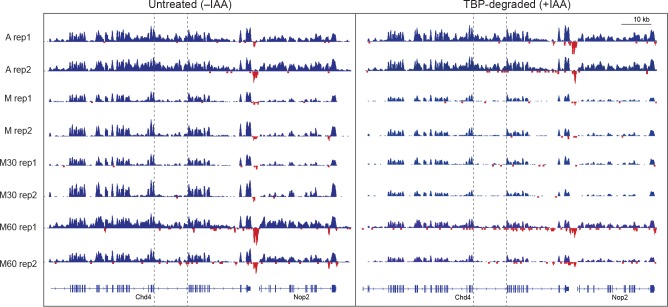
Nascent chr-RNA-seq is highly reproducible.Genomic browser snapshots of sense (blue) and anti-sense (red) reads of each sample and the corresponding replicates for untreated cells and TBP-degraded cells. An intronic region (boxed) is highlighted to indicate levels of newly transcribed RNA.